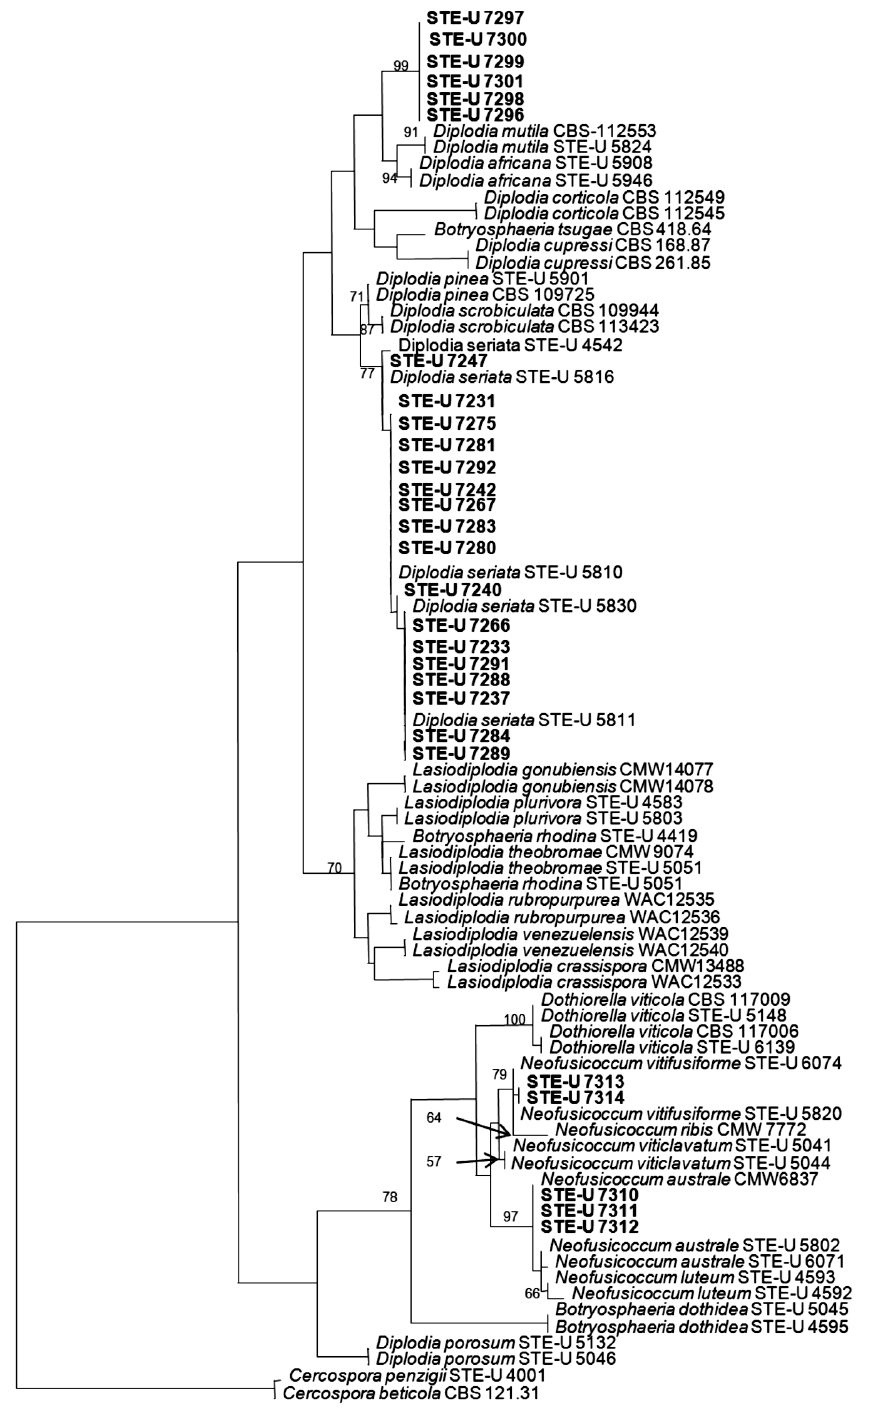
Figure 1. One of 840 most parsimonious trees obtained from ITS sequences of the Botryosphaeriaceae. Bootstrap sup - port values above 50% from 1000 replicates are shown at the nodes. Tree scores include Length = 294, CI = 0.707, RI = 0.931, RC = 0.658, HI = 0.293. Isolates from the present study in